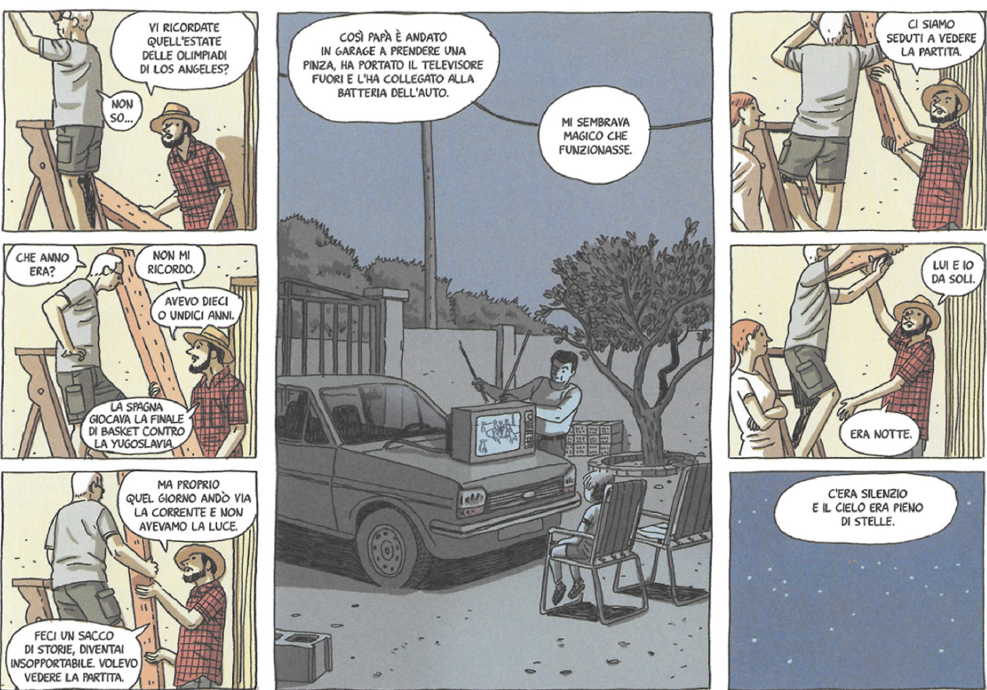
Fig. 11 In the center of the